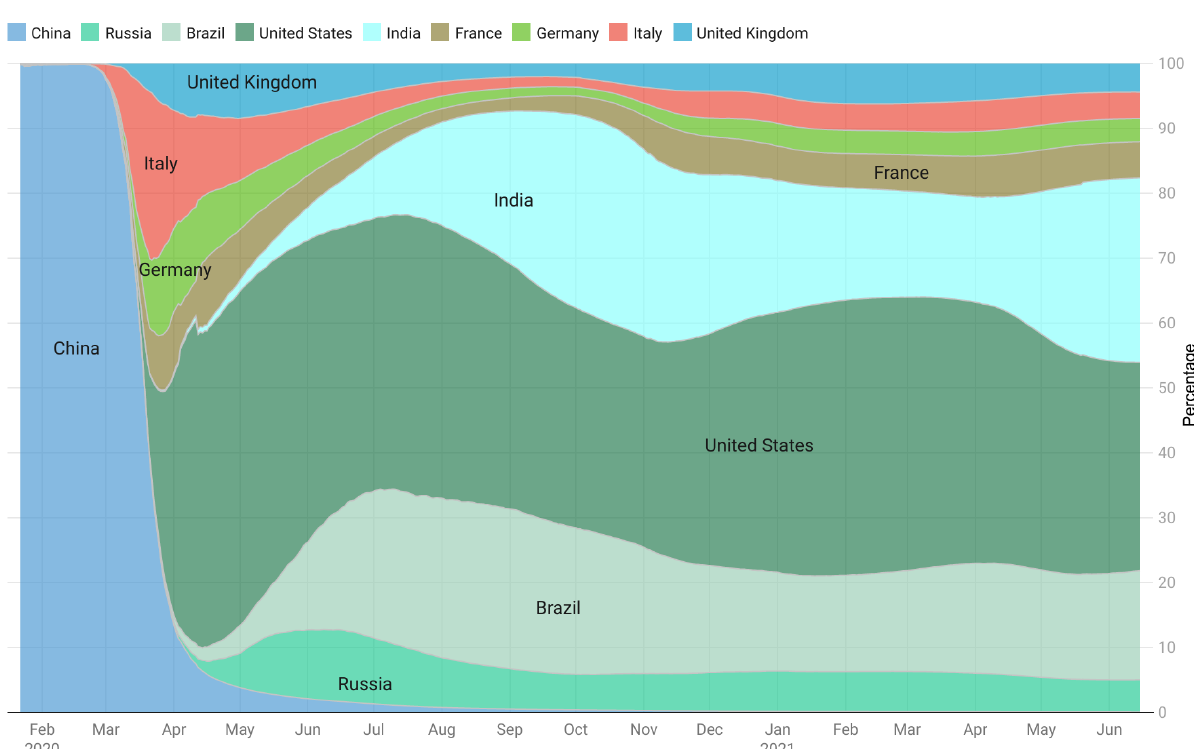
Fig. 3 Percentage of total confirmed cases in selected countries worldwide with high severity of COVID-19 (from January 22, 2020, to June 15, 2021). The selected countries with severe COVID-19 outbreaks are shown. The number of total cases is lower than that of actual total cases due to limited